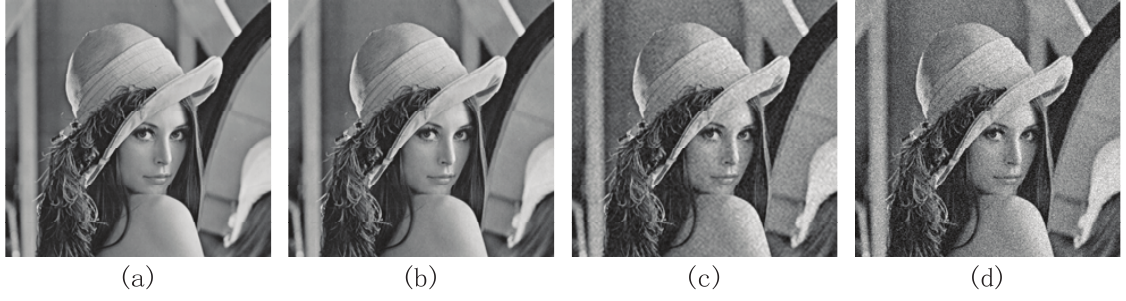
Figure 4: Lena’s reconstructed images. (a) the original image; (b) Chunksize=8 (cid:2) 8, PSNR=38.4dB; (c)